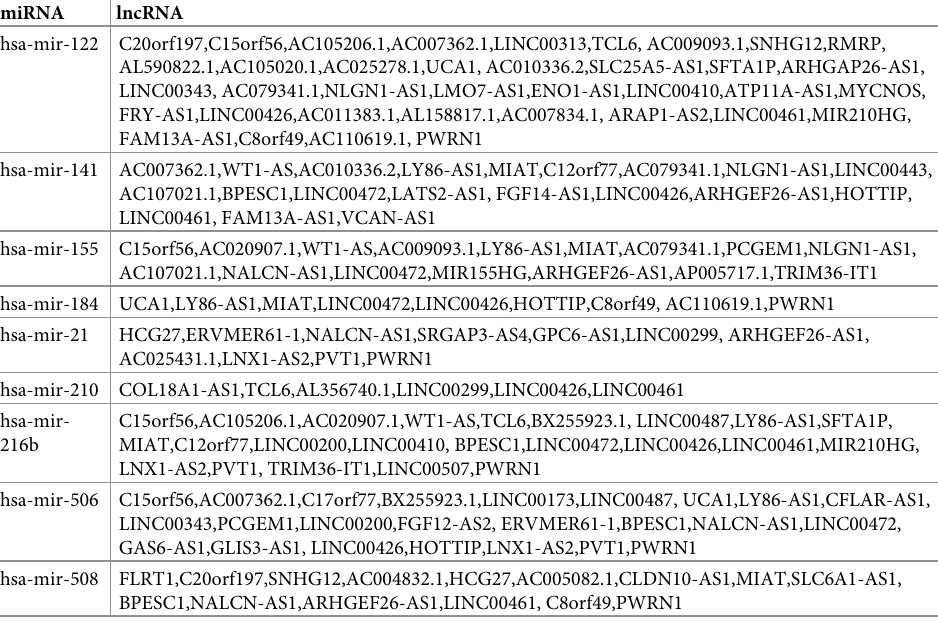
Table 5. Representative relationships between lncRNAs and miRNAs in patients with kidney renal clear cell carcinoma. miRNA